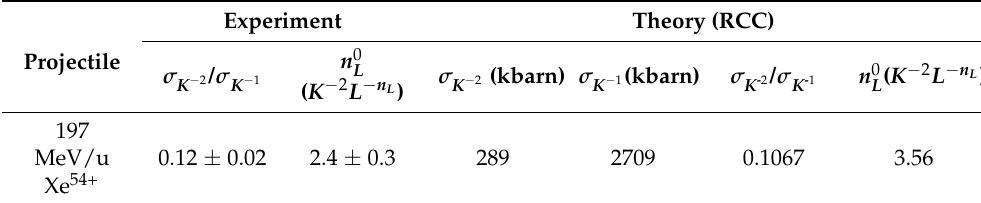
Table 2. Comparison of our experimental results with theory for target single and double K -shell vacancy production. The uncertainty of intensity ratio comes from the uncertainties of the fitting parameters. The uncertainty of the deduced mean L -vacancies is estimated by detection error and fitting